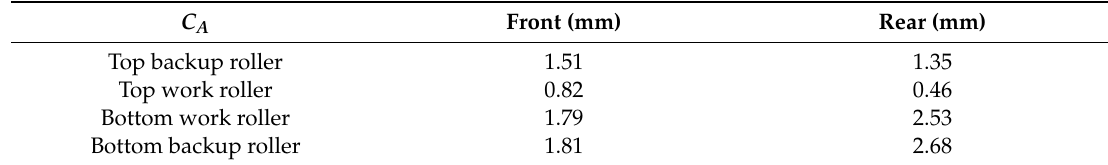
Table 4. On-site clearances C A in finishing mill in CSC Kaohsiung.